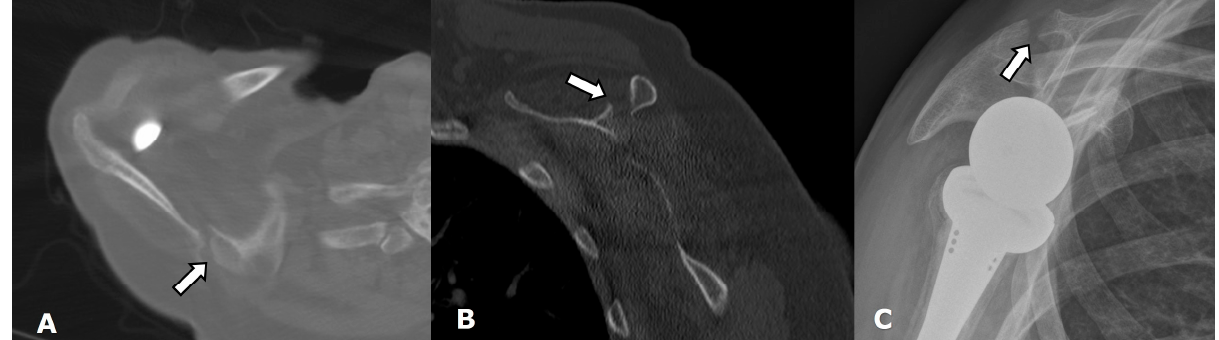
Figure 19. ( A ) Axial and ( B ) parasagittal CT images and ( C ) a scapular Y radiograph demonstrate a scapular fracture (arrow) following RTSA.